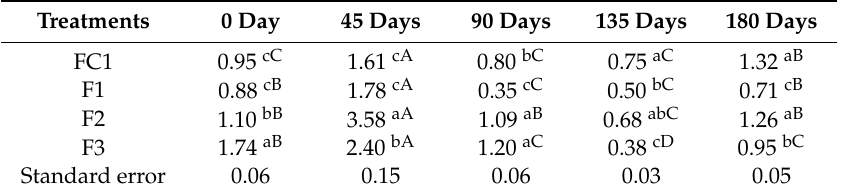
Table 2. Malonaldehyde (mg / kg) values in salted meat treatments during storage. Treatments 0 Day 45 Days 90 Days 135 Days 180 Days FC1 0.95 cC 1.61 cA 0.80 bC 0.75 aC 1.32 aB F1 0.88 cB 1.78 cA 0.35 cC 0.50 bC 0.71 cB F2 1.10 bB 3.58 aA 1.09 aB 0.68 abC 1.26 aB F3 1.74 aB 2.40 bA 1.20 aC 0.38 cD 0.95 bC Standard error 0.06 0.15 0.06 0.03